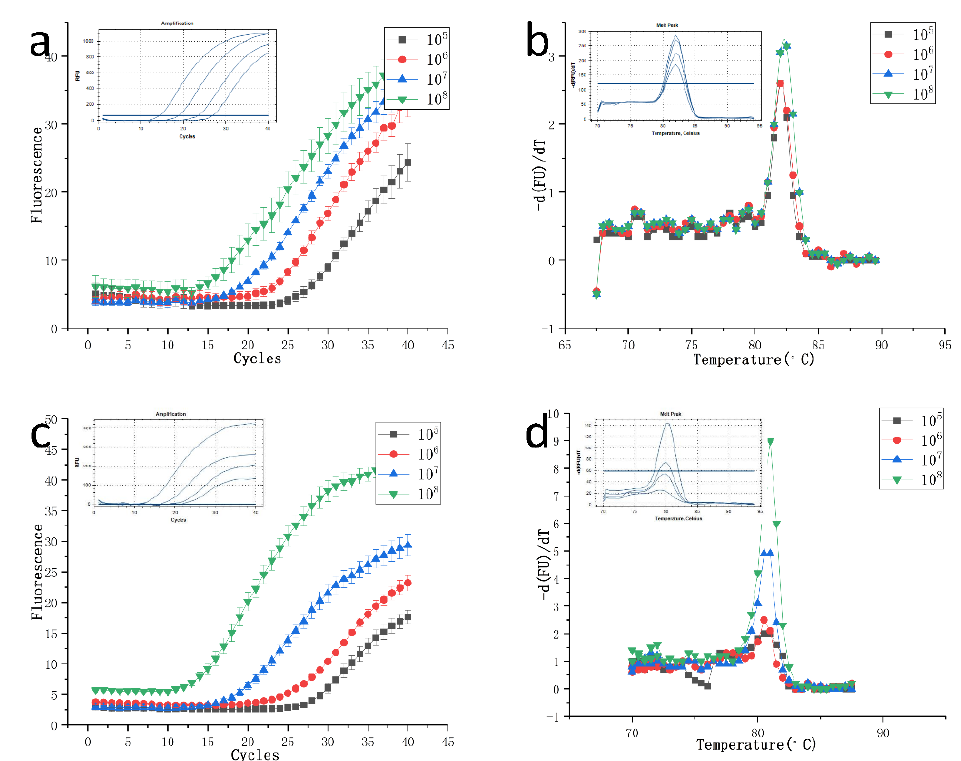
Figure 5. Comparison of the amplification and dissolution curves of H7N9 and pGEM-3Zf ( + )1 with those obtained on a commercial instrument. Curves obtained by the real-time PCR amplification system under the same conditions are shown in the upper left of each figure. ( a ): The amplification curves of H7N9 from the homemade system are shown. ( b ): The melt curve analysis of the H7N9 obtained from the homemade system. The first derivative change in fluorescence intensity as a function of temperature is shown. ( c ): The amplification curves of H7N9 from the homemade system are shown. ( d ): The melt curve analysis of the H7N9 obtained from the homemade system. The first derivative change in fluorescence intensity as a function of temperature is shown.